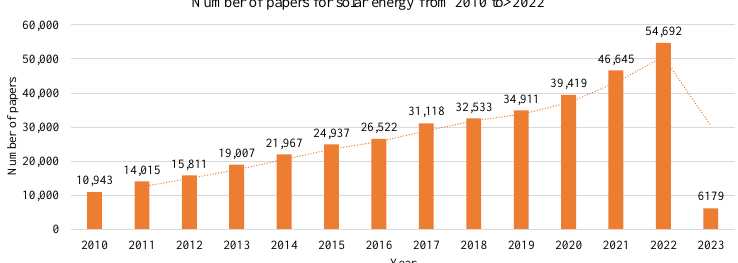
Figure 6. Development of research in the field of solar energy (2010–2022). The dotted line represents the moving average of the published paper. (>2022 represents continuing